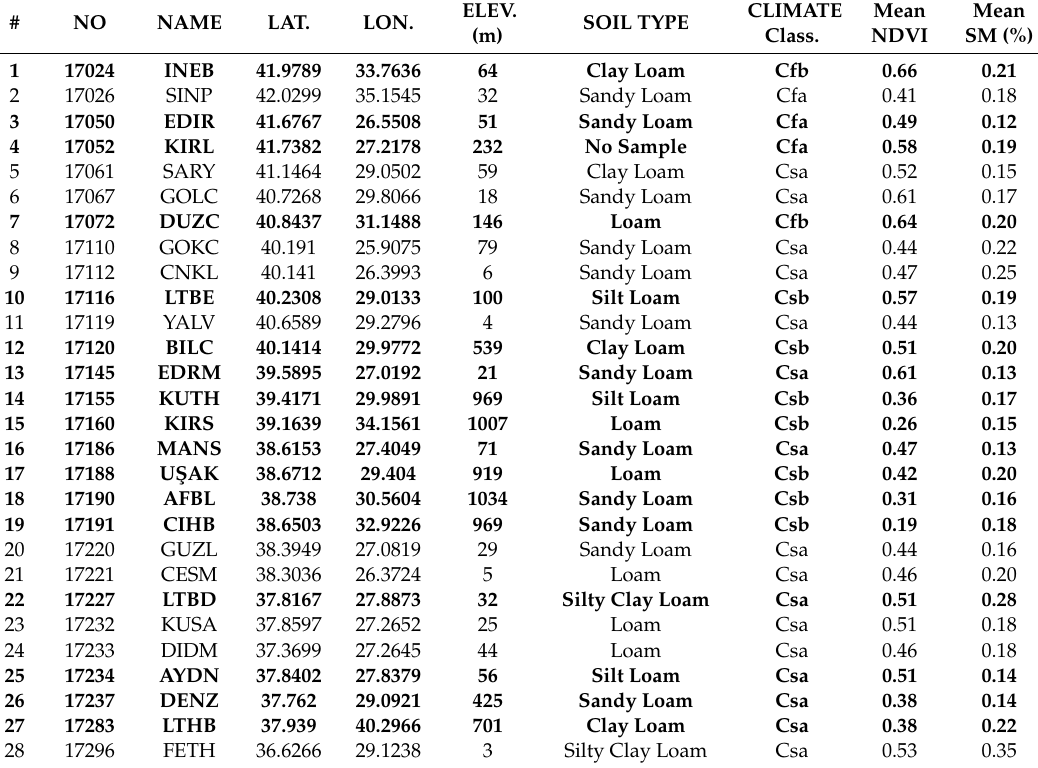
Table A1. Characteristics of soil moisture stations used in this